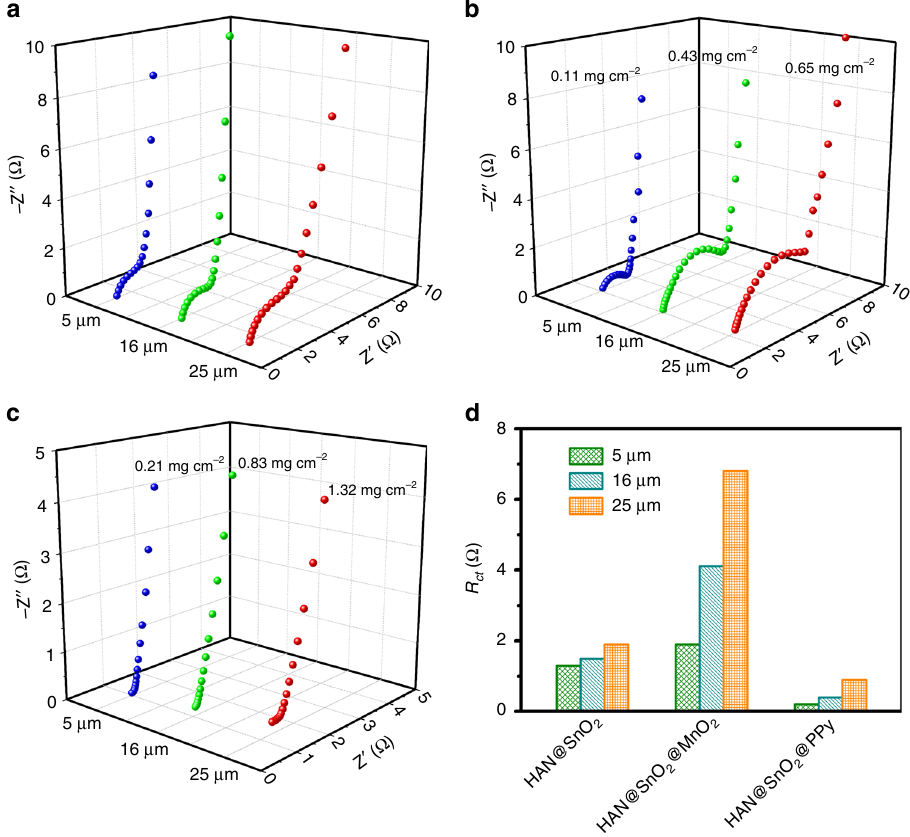
Fig. 4 Electrochemical impedance properties comparison. Nyquist plots of a HAN@SnO 2 //HAN@SnO 2 , b HAN@SnO 2 @MnO 2 //HAN@SnO 2 @MnO 2 , and c HAN@SnO 2 @PPy//HAN@SnO 2 @PPy MSCs with different pore depths of HAN. d Comparison of the charge transport resistance ( R ct ) of different HAN-based